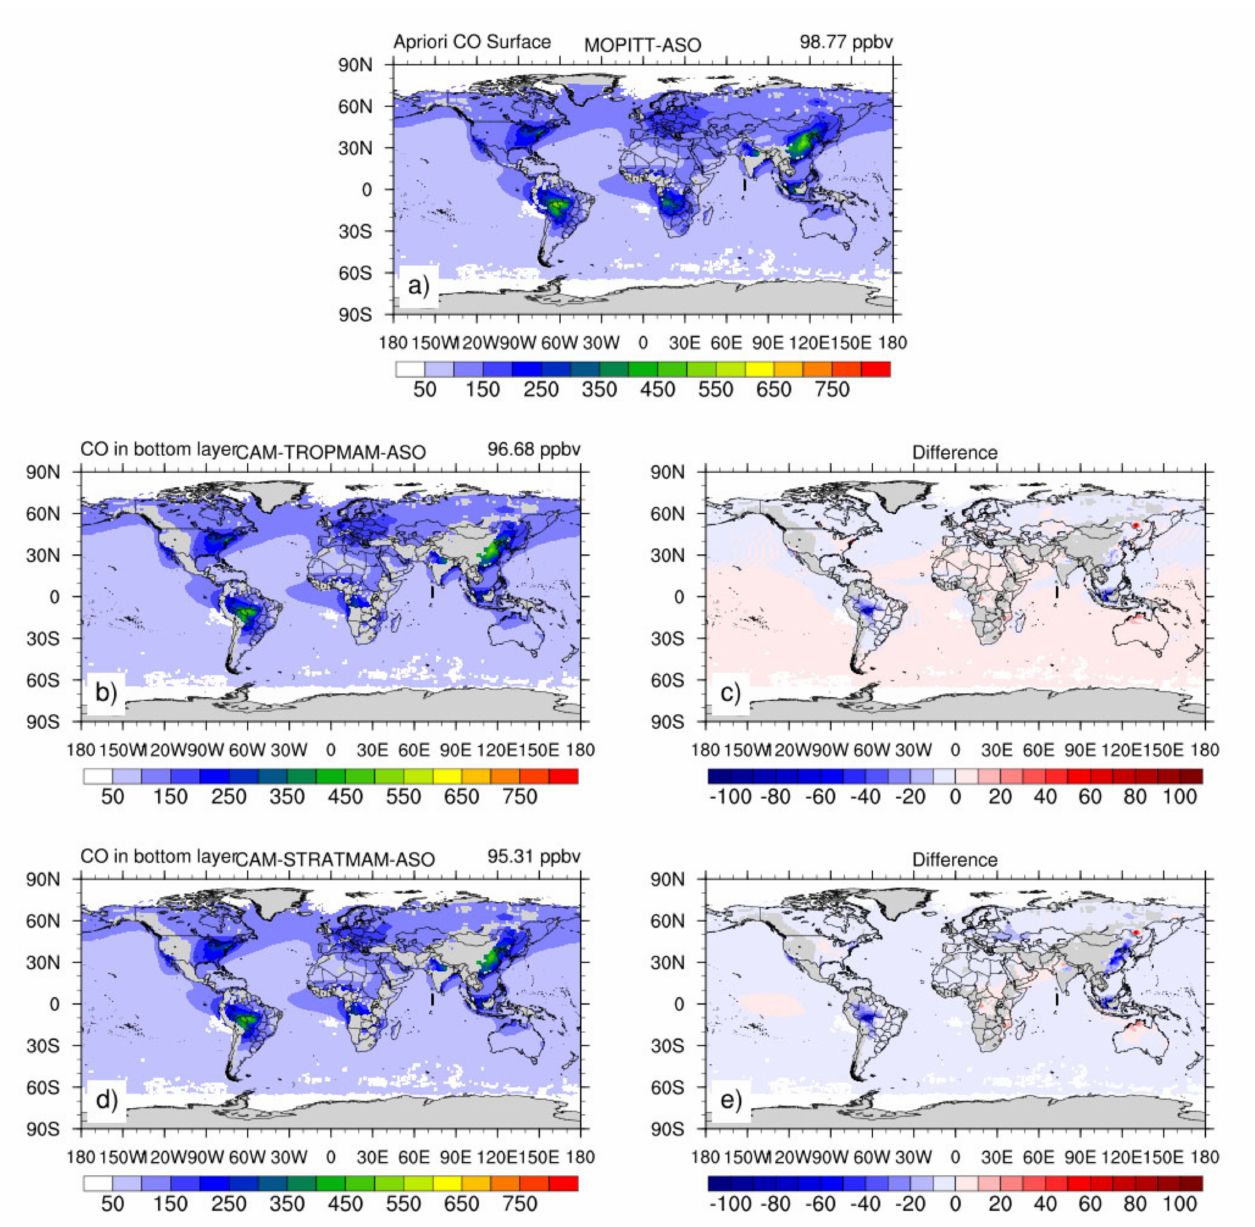
Figure 5. ( a ) CO (ppb) observed by MOPITT sensor for August-September-October (ASO), in the period of 2010–2014, ( b ) CO simulated by the CAM5-MAM3 model using tropospheric chemistry and ( d ) tropospheric/stratospheric chemistry mechanisms using the calculations of Equation (4). The right side of the figure shows the model difference minus the observation (MOPITT), ( c ) for tropospheric chemistry and ( e ) for tropospheric/stratospheric